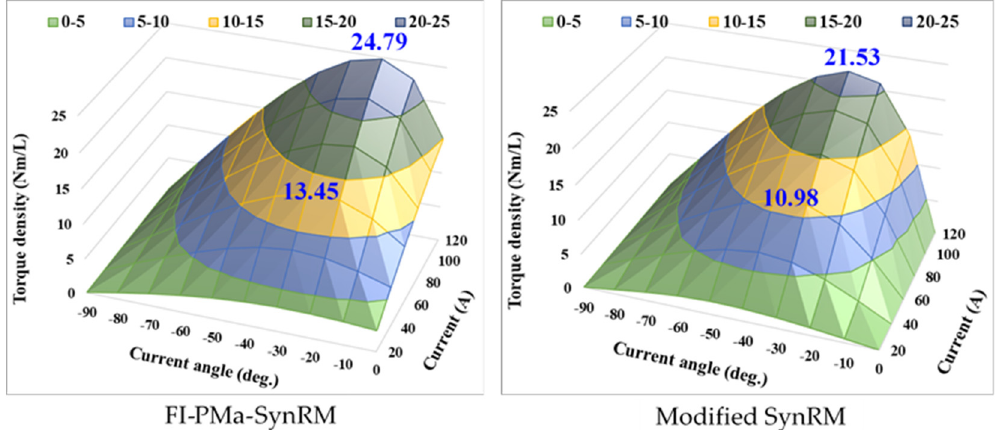
Figure 11. Comparison of torque density between FI-PMa-SynRM and Modified SynRM.